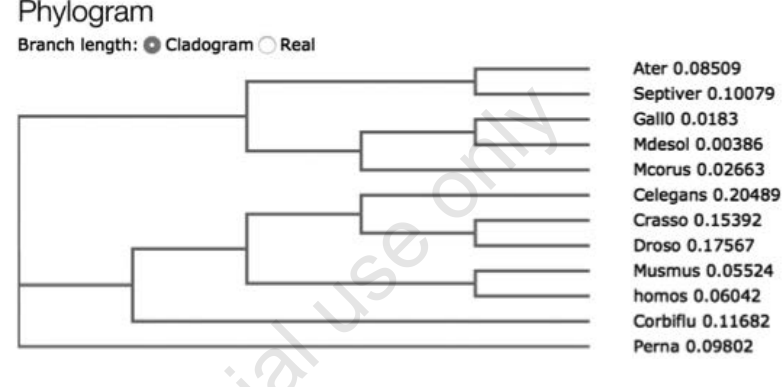
Figure 1. Simplified cladogram showing relationships between mussel species based upon Hsp70 sequence. The cladogram was constructed using the CLUSTAL W (1.83)